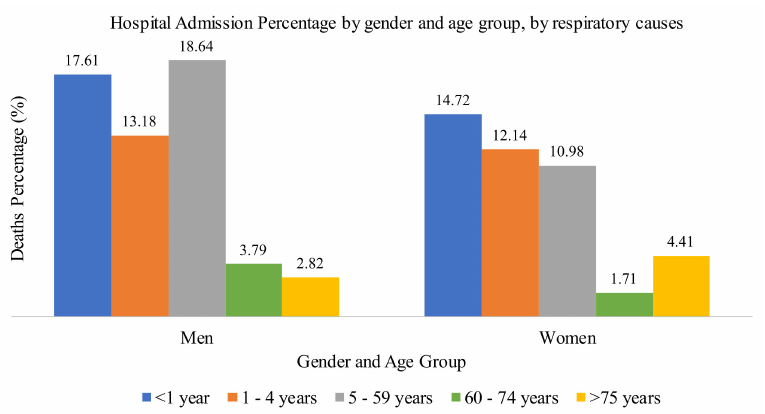
Figure 8. Hospital admission percentage by gender and age group for respiratory causes.